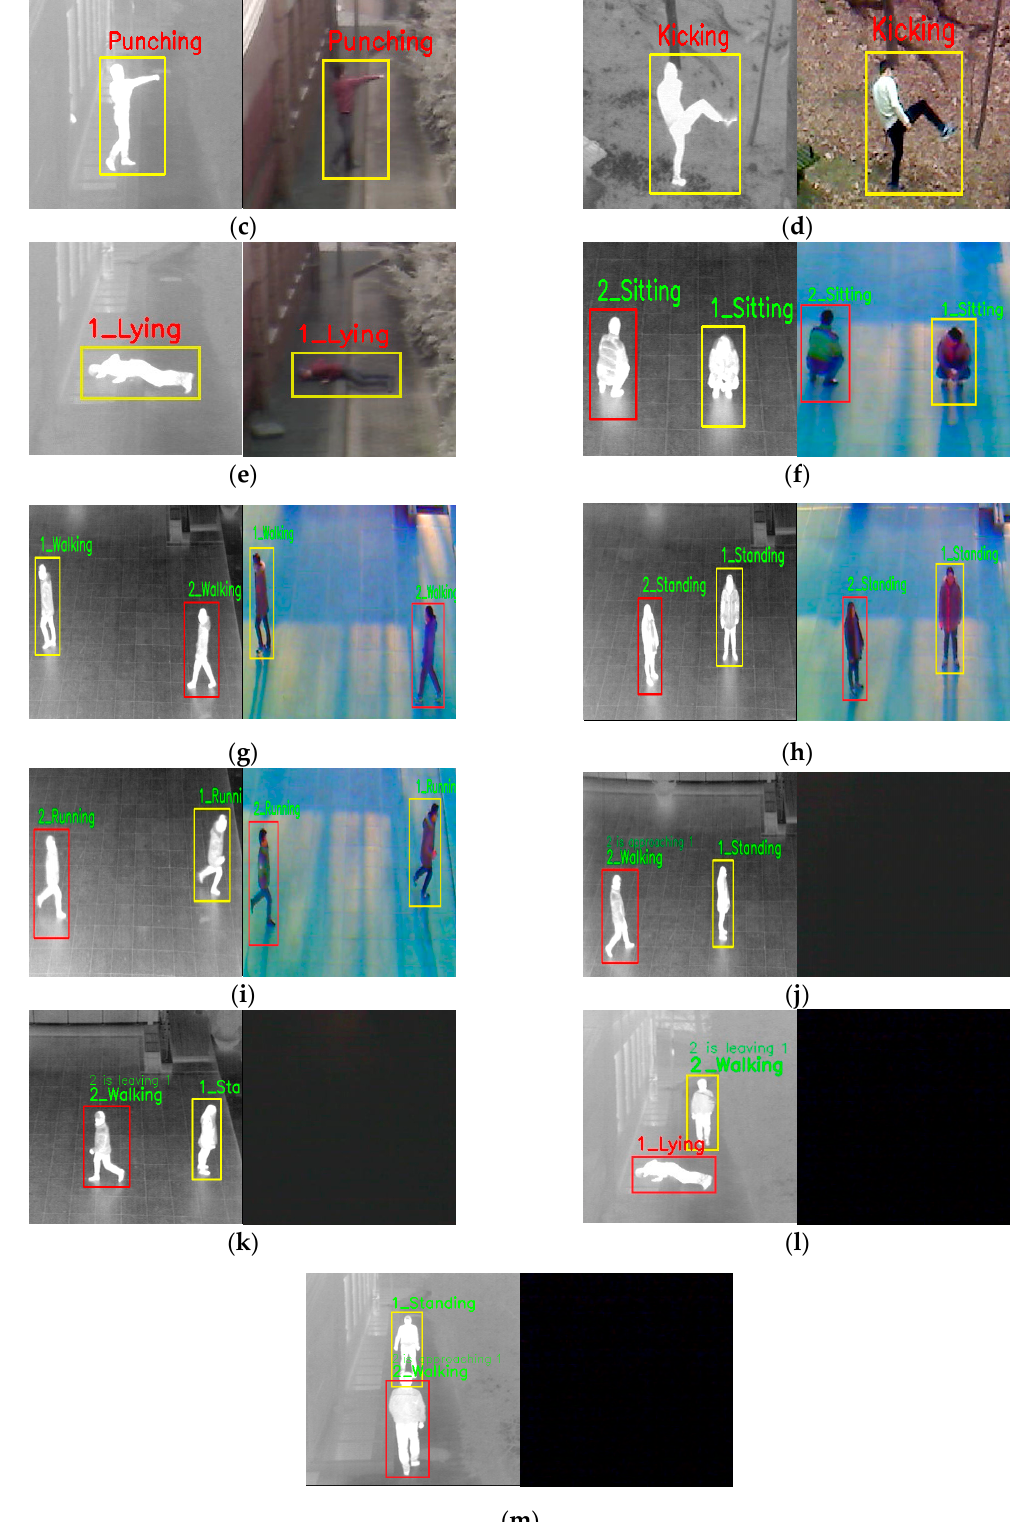
Figure 13. Examples of correct behavior recognition. In ( a – m ), the images on the left and right are obtained by thermal and visible light camera, respectively. ( a ) Waving with two hands; ( b ) waving with one hand; ( c ) punching; ( d ) kicking; ( e ) lying down; ( f ) sitting; ( g ) walking; ( h ) standing; ( i ) running; ( j ) and ( m ) approaching (nighttime); ( k ) and ( l ) leaving (nighttime).